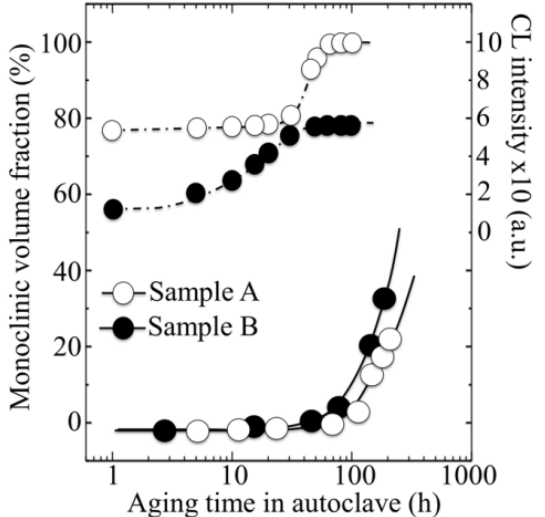
Figure 9. Semi-logarithmic-scale plots of monoclinic phase fractions and amount of annihilated oxygen vacancies as a function of exposure time in hydrothermal environment. The size of the used symbols corresponds to the standard deviation of the measured parameters.